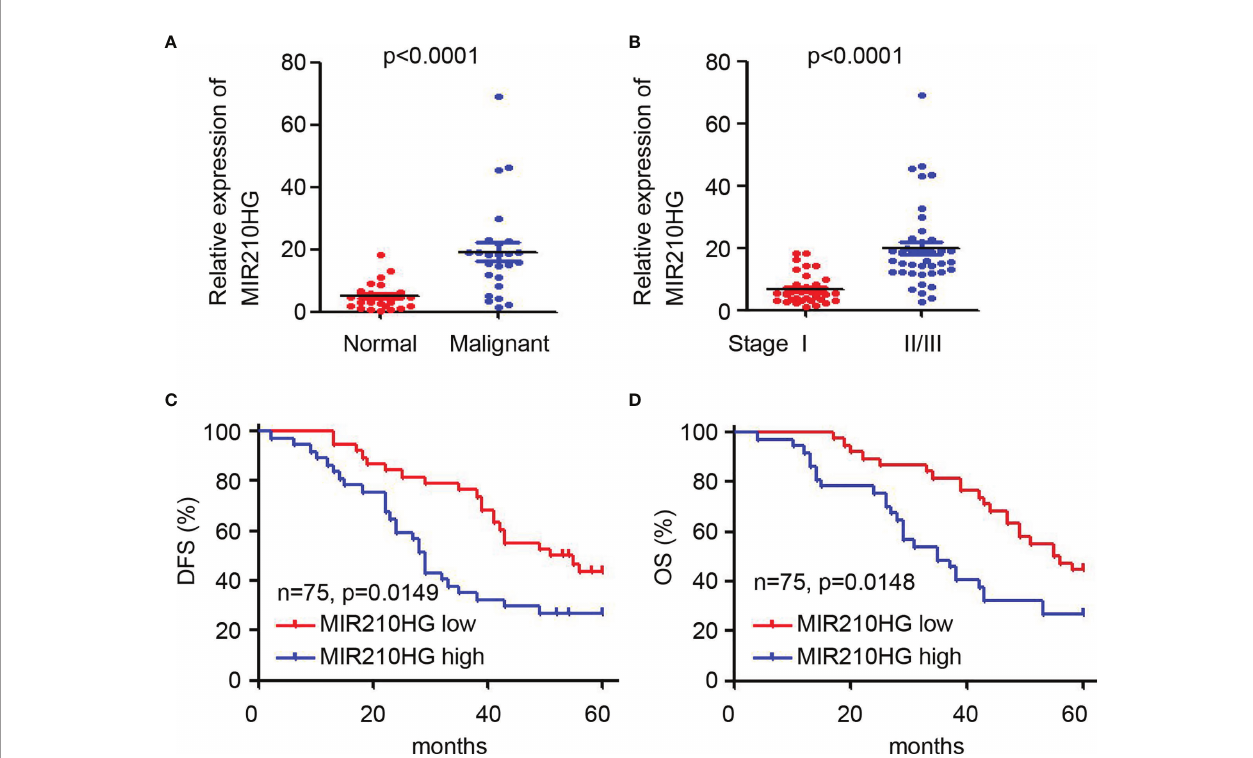
FIGURE 6 | Upregulation of lncRNA-MIR210HG predicts poor prognosis of ovarian cancer patients. (A) qPCR analysis of lncRNA-MIR210HG expression in adjacent normal and malignant tissues of ovarian cancer patients. (B) qPCR analysis of lncRNA-MIR210HG expression in malignant tissues from stage I or stage II/III ovarian cancer patients. (C, D) Ovarian cancer patients were dived into lncRNA-MIR210HG high and low expression group based on the median expression of lncRNA- MIR210HG expression in 75 malignant tissues. Analysis of disease-free survival (DFS) and overall survival (OS) time in the lncRNA-MIR210HG high and low